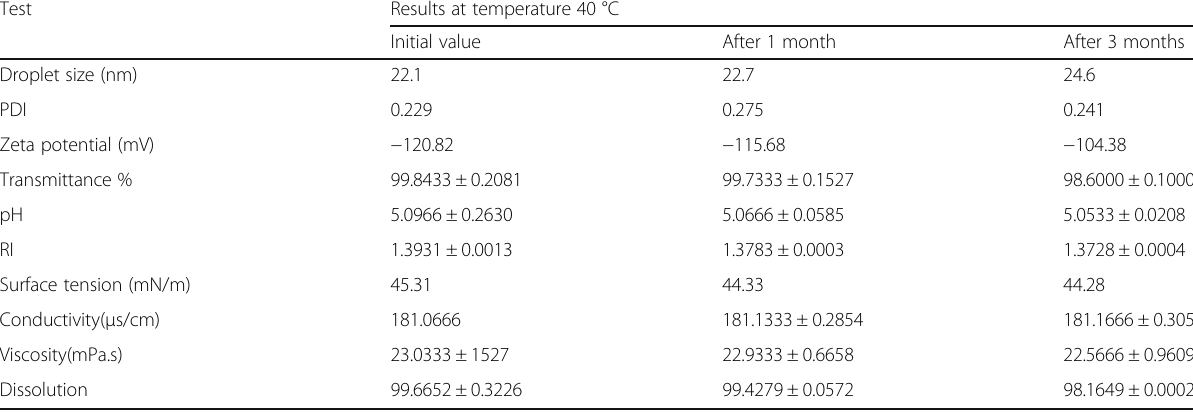
Table 9 Stability of candesartan cilexetil optimum nanoemulsion formula